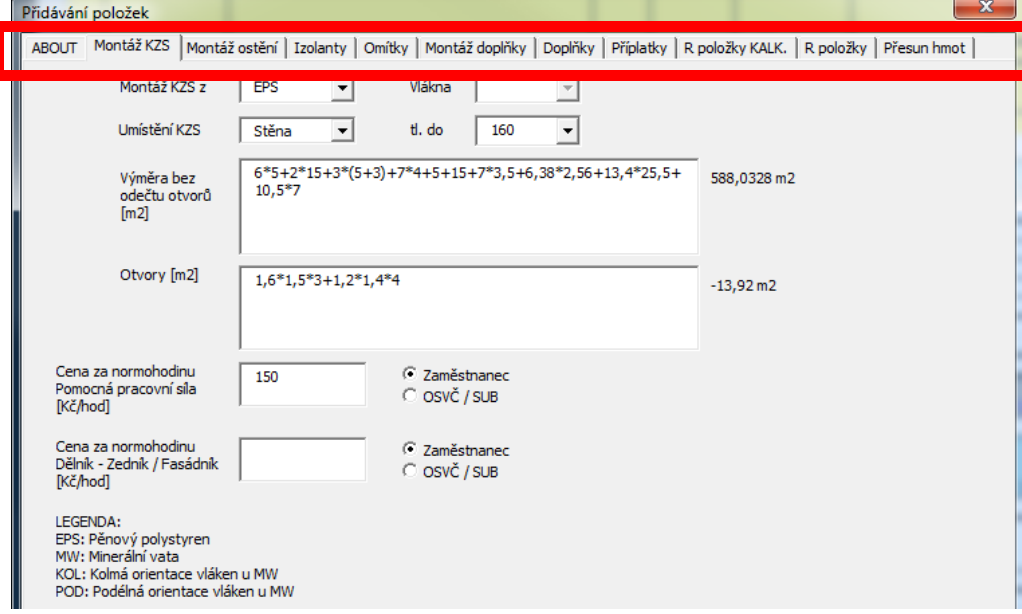
Figure 5: Uživatelský formulář pro přidávání různých druhů položek (zdroj: